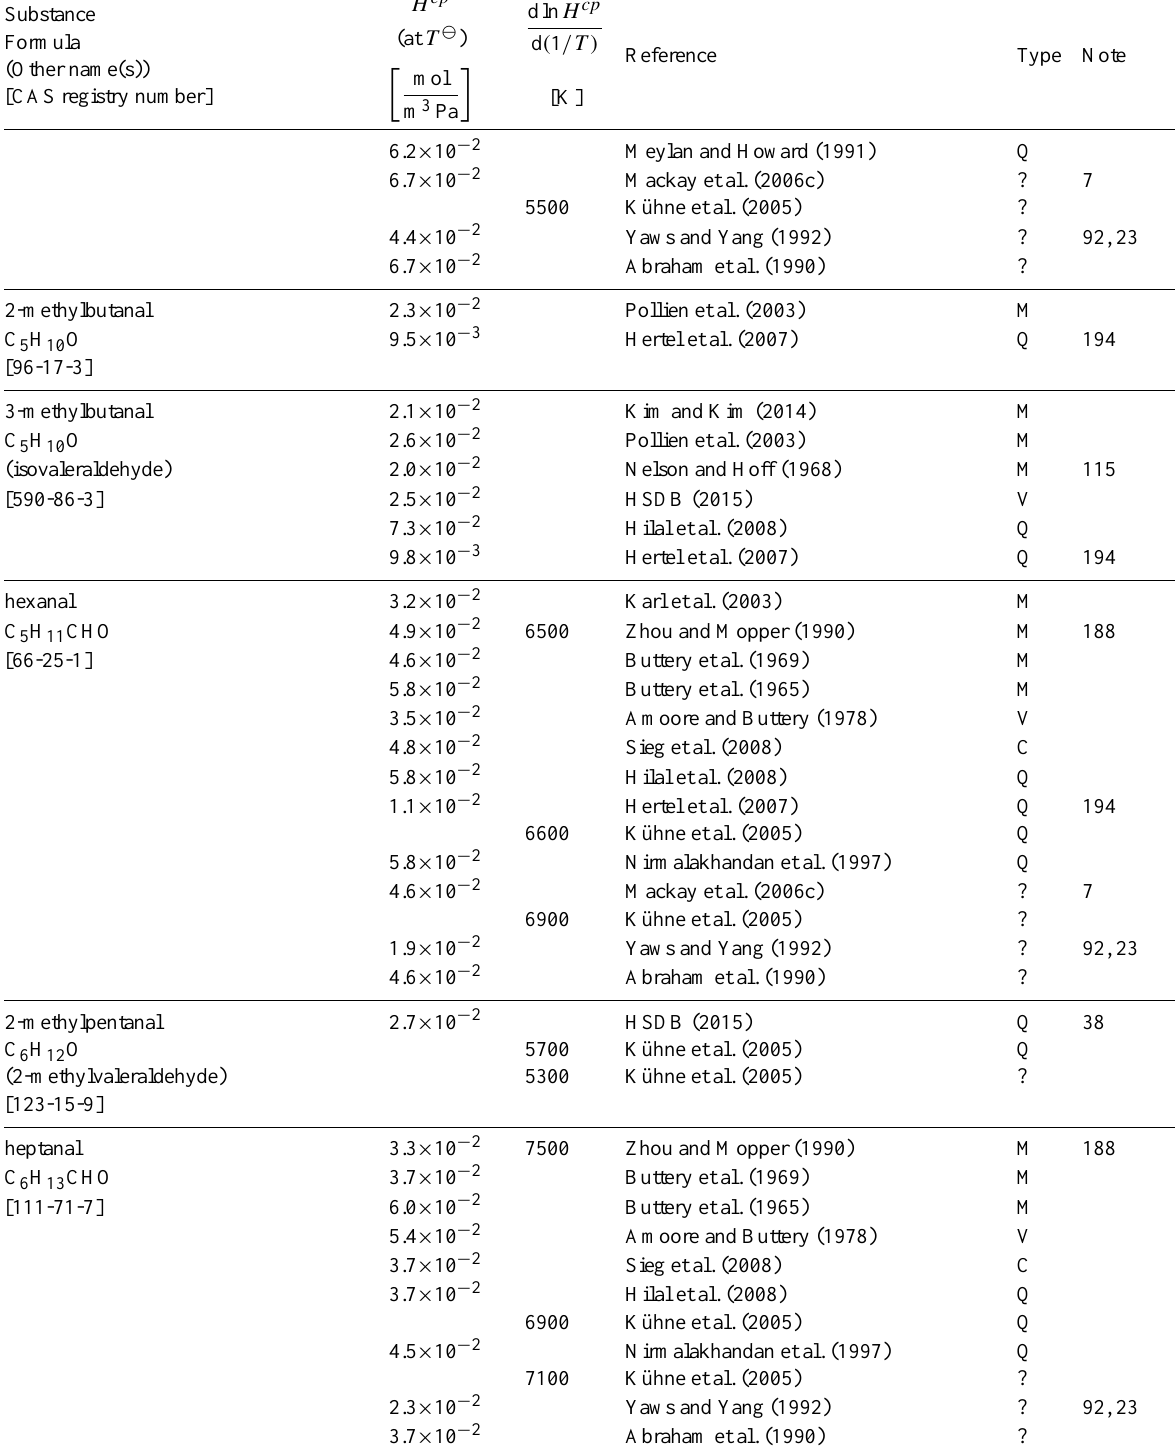
Table 6: Henry’s law constants for water as solvent